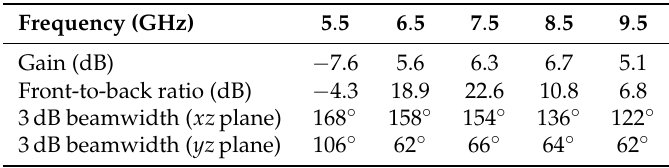
Table 2. Maximum gain and 3dB beamwidths of Antenna II